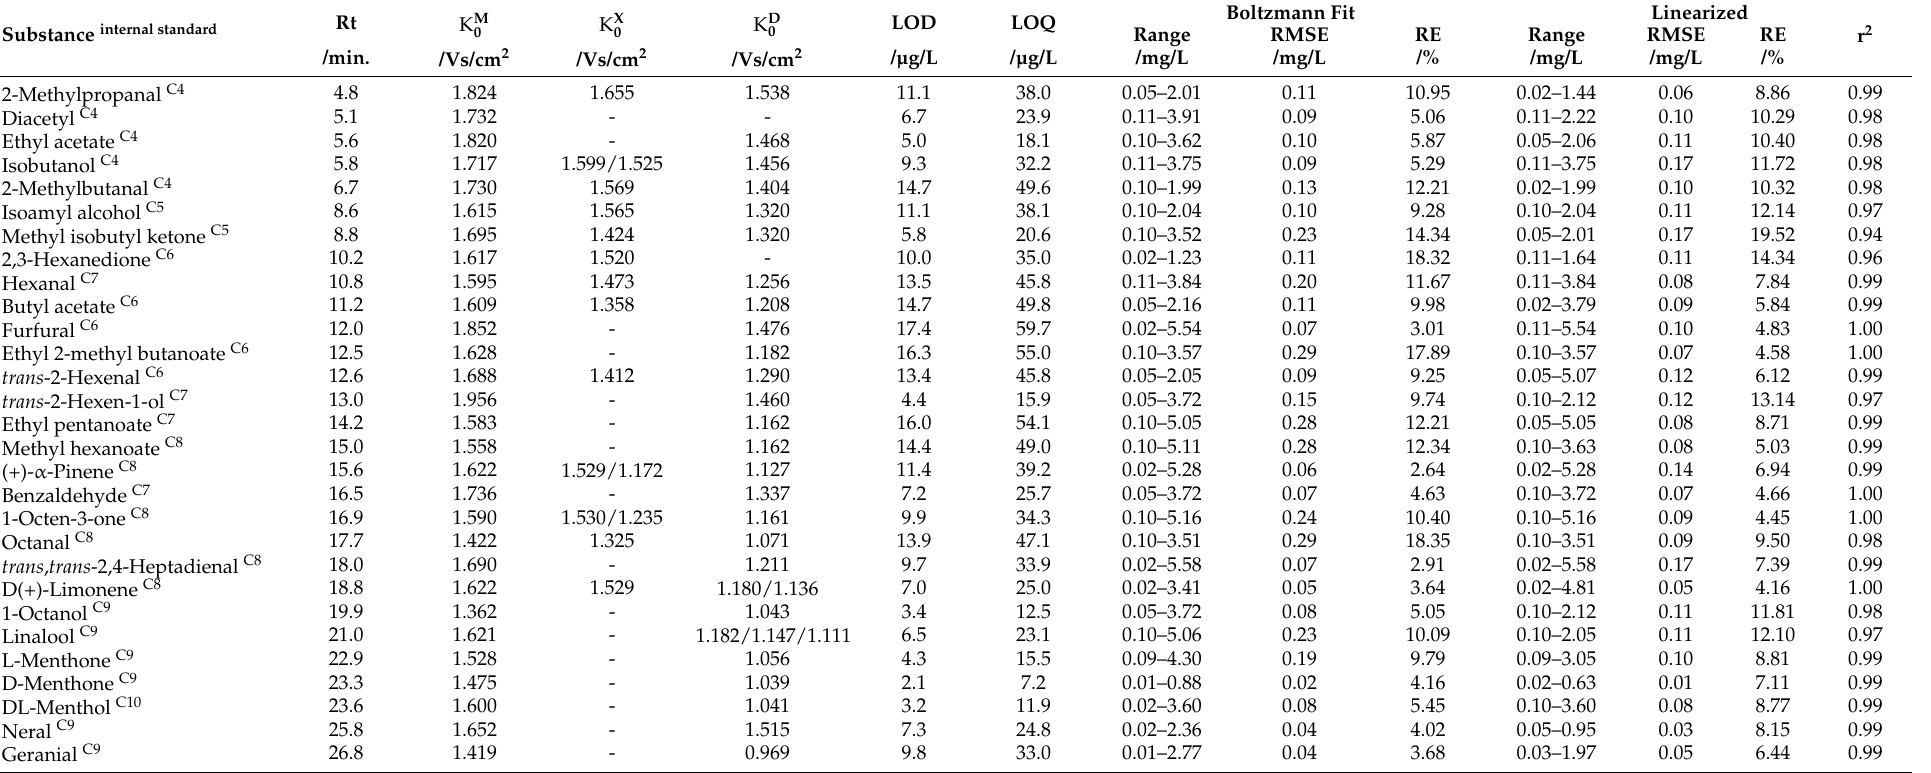
Table 1. Summary of the results for the analyzed substances used in the method validation, sorted by their retention time (Rt), including the reduced mobility (K 0 ) for the monomer ( M ), mixed dimer ( X ), and dimer ( D ) signals, the limit of detection and quantitation (LOD and LOQ), the concentration range that was used for the Boltzmann fit and the linearized fit, including the root mean squared error (RMSE), the relative error (RE), and the coefficient of determination (r 2